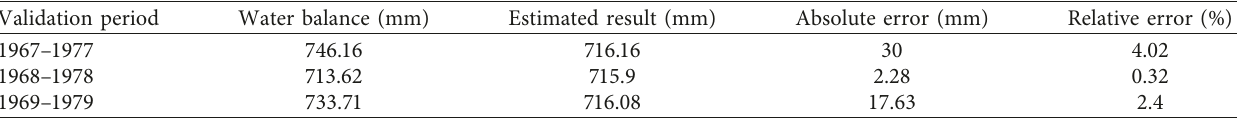
Table 2: Estimation error of actual evapotranspiration in the upper reach of the Huaihe River